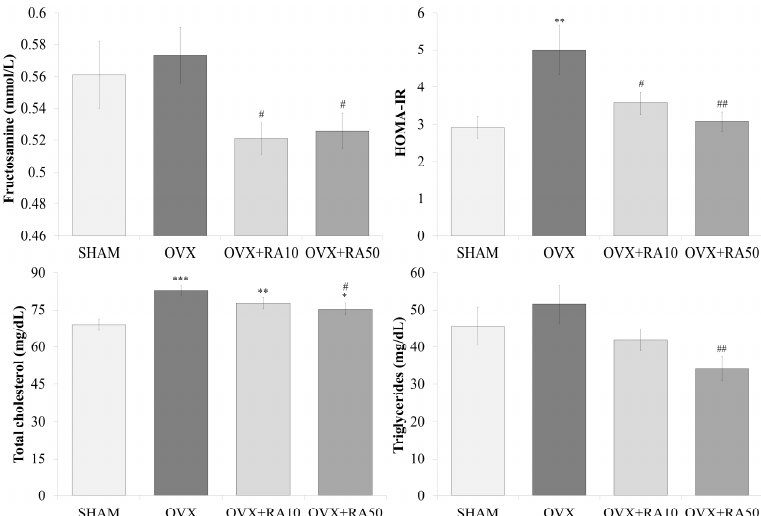
Figure 3 . Effects of rosmarinic acid on the selected serum parameters related to glucose and lipid metabolism in ovariectomized rats. Rosmarinic acid at doses of 10 mg/kg (OVX + RA10) and